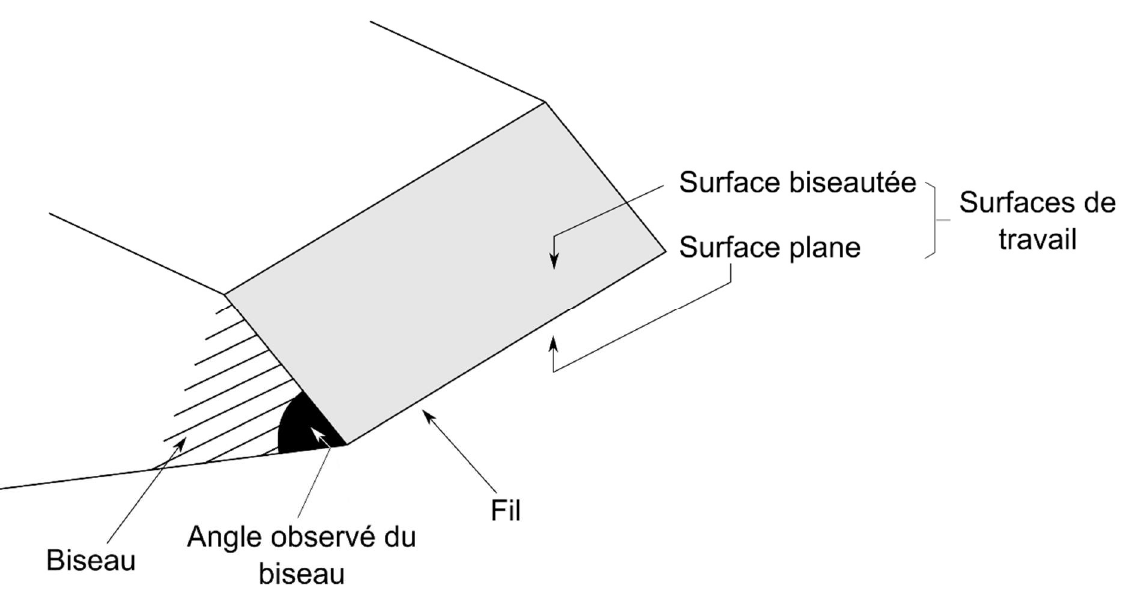
Figure 13. Termes utilisés pour décrire la géométrie de la partie transformative d'un outil (modifié de Soriano et al.